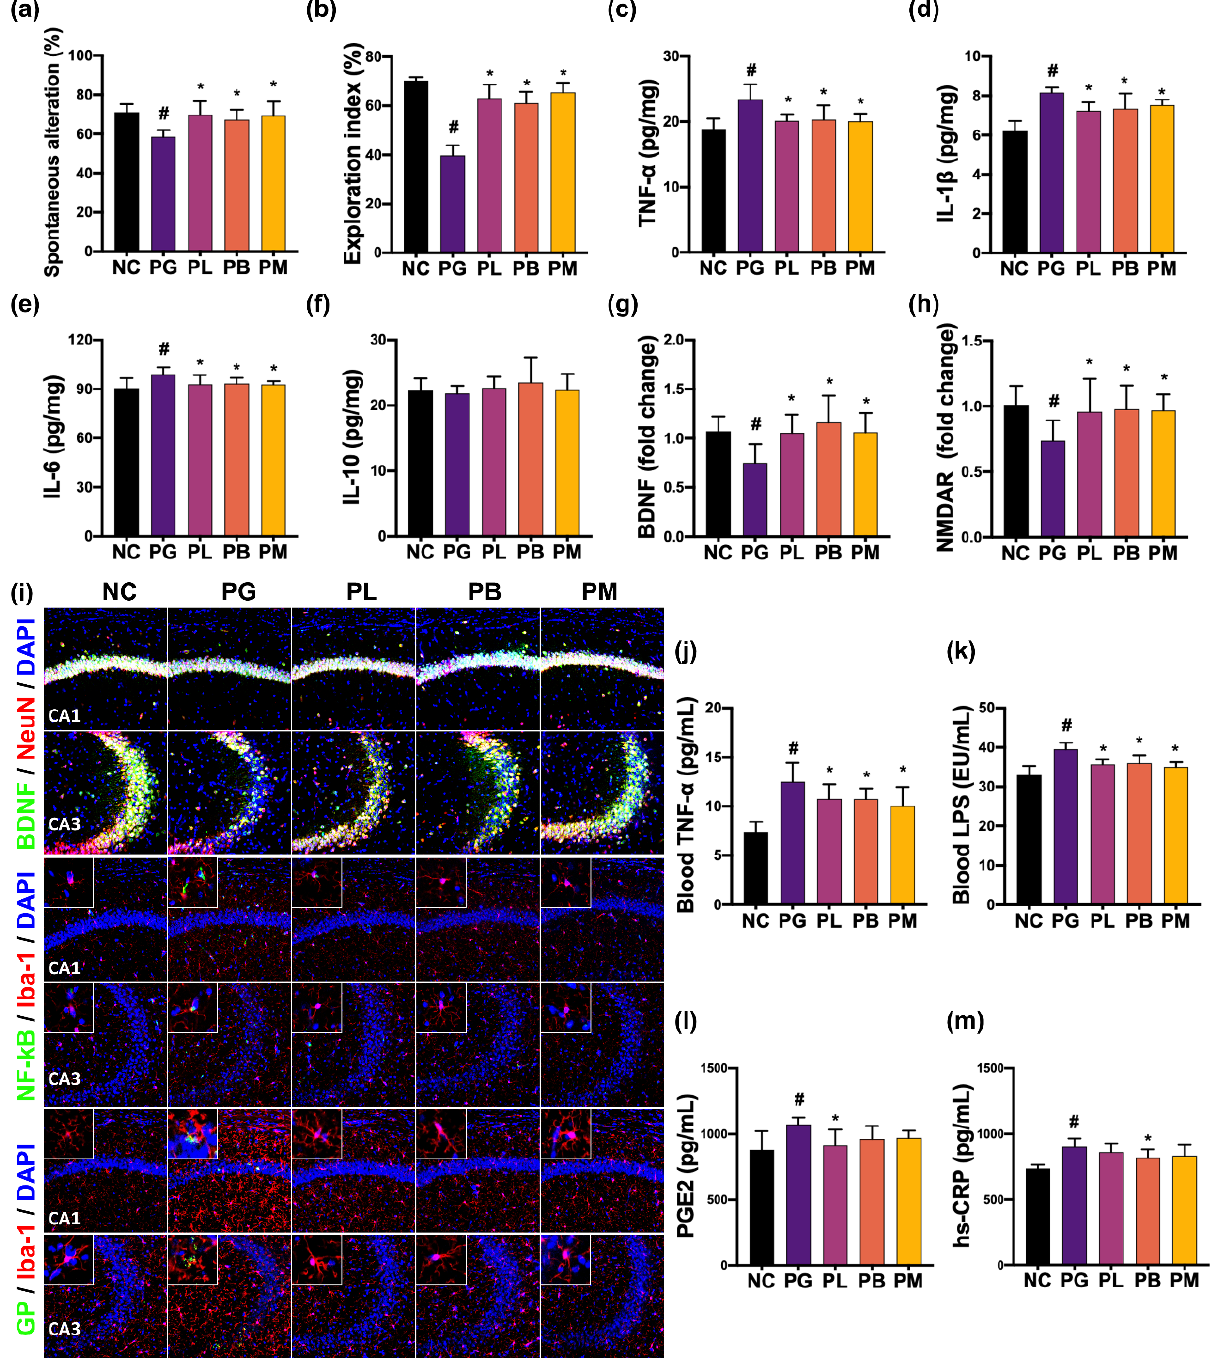
Figure 3. NK357 and NK391 alleviated PG-induced CI in mice. Effects on spontaneous alternation ( a ) and exploration ( b ). Effects on hippocampal TNF- α ( c ), IL-1 β ( d ), IL-6 ( e ), and IL-10 ( f ), BDNF ( g ), and NMDAR expression ( h ). ( i ) Effects on hippocampal BDNF + NeuN + cells, NF- κ B + Iba1 + , and GP + Iba1 + cell populations. Effects on blood TNF- α ( j ), LPS ( k ), PGE2 ( l ), and hs-CRP ( m ) levels. Data are indicated as mean ± SD ( n = 6). # p < 0.05 vs. NC. * p < 0.05 vs. PG.